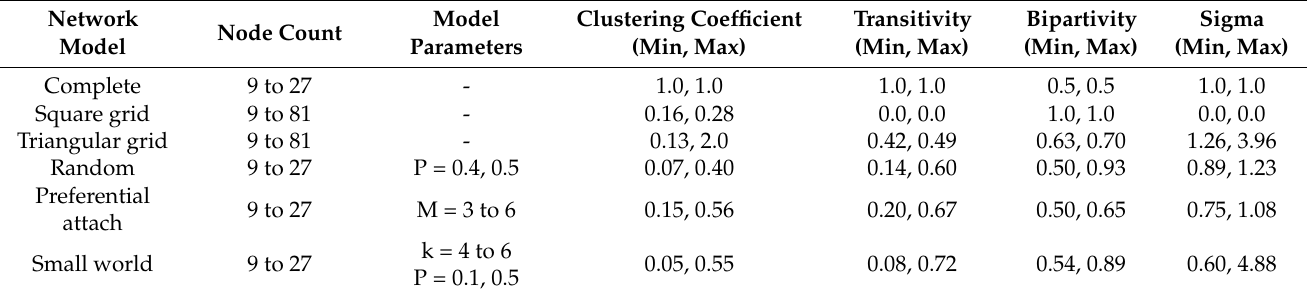
Table 2. Parameter values of simulated networks.